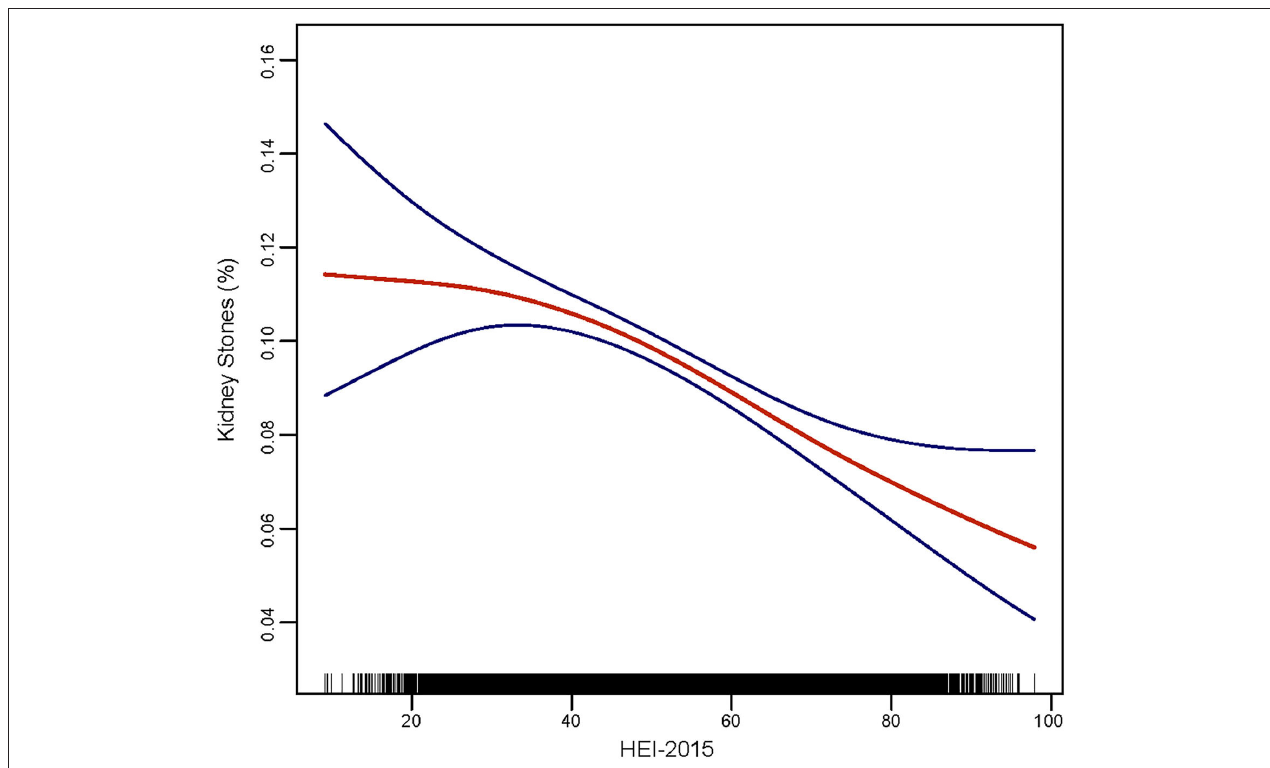
FIGURE 2 | Smooth curve fitting of kidney stones and